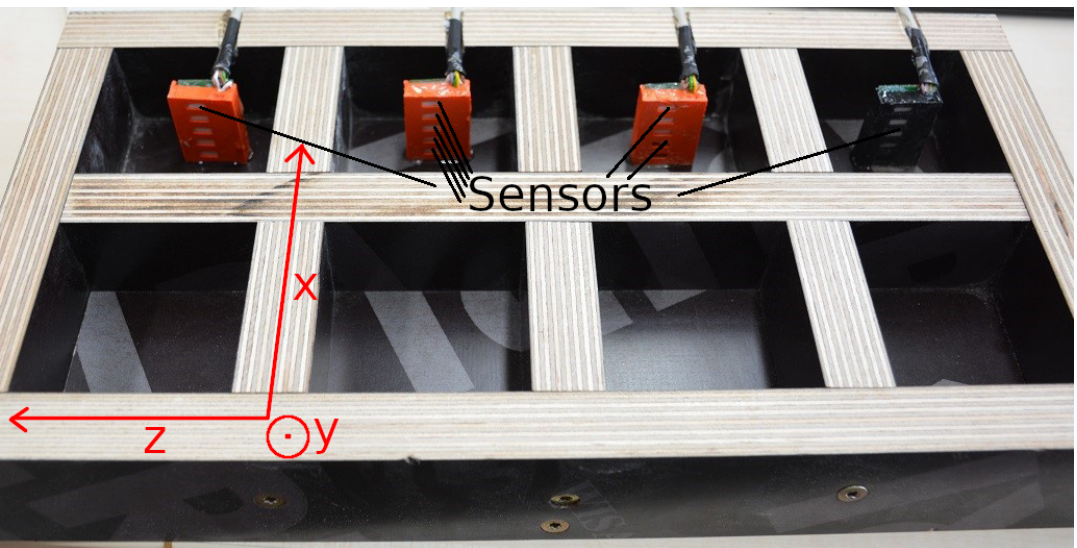
Figure 1. Formwork in which the screed was added. This formwork was used to create eight samples; in four of these samples sensors were placed for electrical measurements. Those samples without electrical sensors were used for destructive methods. 16 h after preparation the samples were removed from the formwork and measured individually. The coordinate system clarifies the orientation of the sensors in the sample relative to the neutron beam, which points in direction of the z